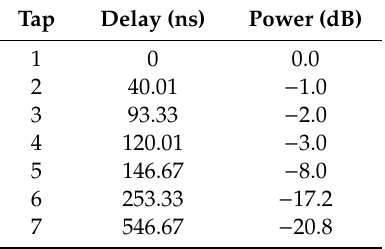
Table 6. Modified EPA delay profile; CFO = 5 kHz; mean = 0.3406, variance = 0.1091.